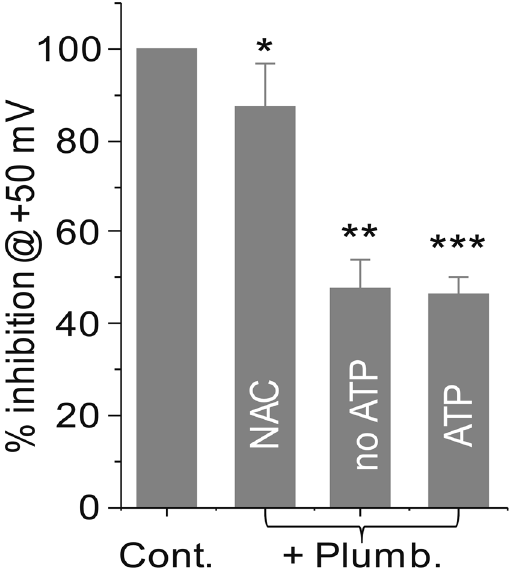
Figure 7. Oxidative stress is responsible for NKA inhibitory activity of plumbagin. The average percent inhibition of the outward current measured at + 50 mV in CTAC cells treated with vehicle, plumbagin (5 µ M), plumbagin (5 µ M with ATP (5 mM- supplied in pipet solution) and cells pretreated with NAC (2 mM) prior to exposure with plumbagin (5 µ M) is plotted. Each bar is average data obtained from > 3 individual CTAC cells. * p = 0.306605, ** p = 0.000866 and *** p = 0.000177 compared to vehicle